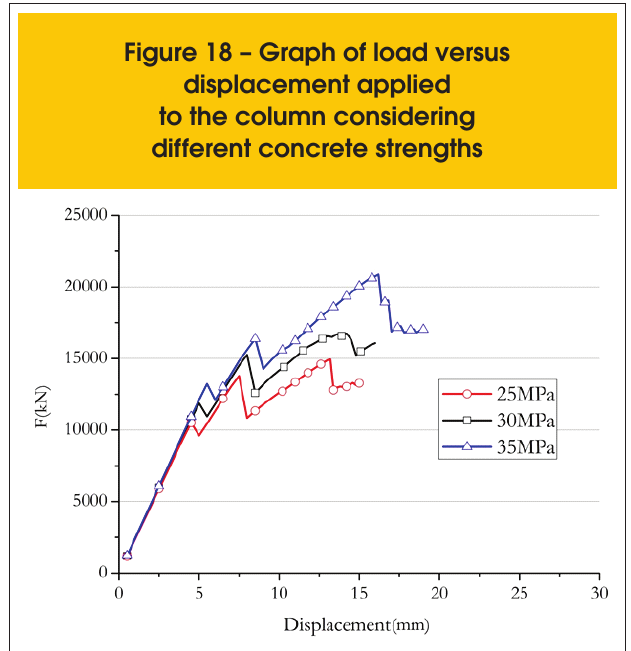
Figure 18 – Graph of load versus displacement applied to the column considering different concrete strengths